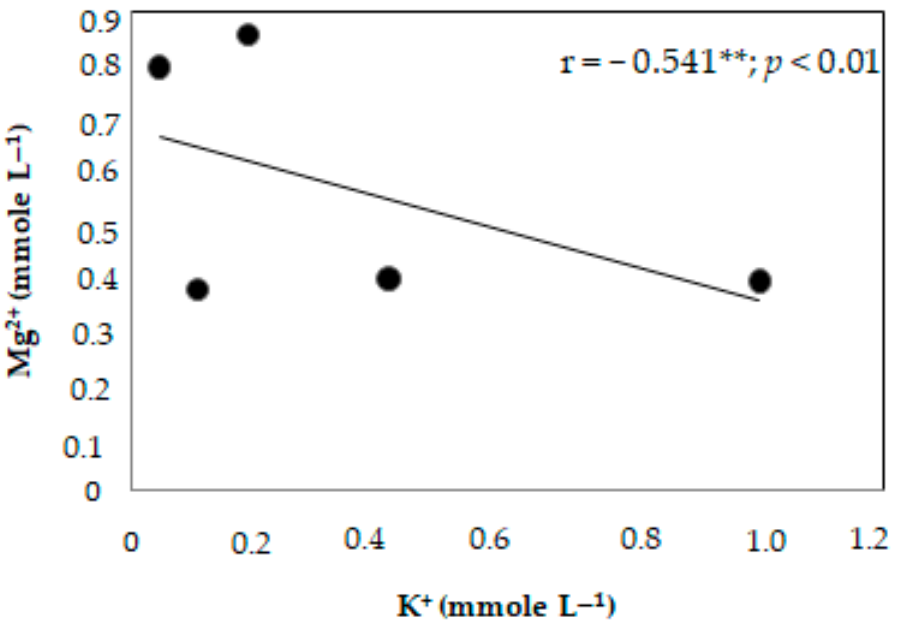
Figure 4. Linear regression showing the relationship between magnesium (Mg 2+ ) and potassium (K + ) concentrations in groundwater irrigated soils. Mg 2+ and K + concentrations are across the two areas of study and averaged across all five depths. ** Significant at p < 0.01.